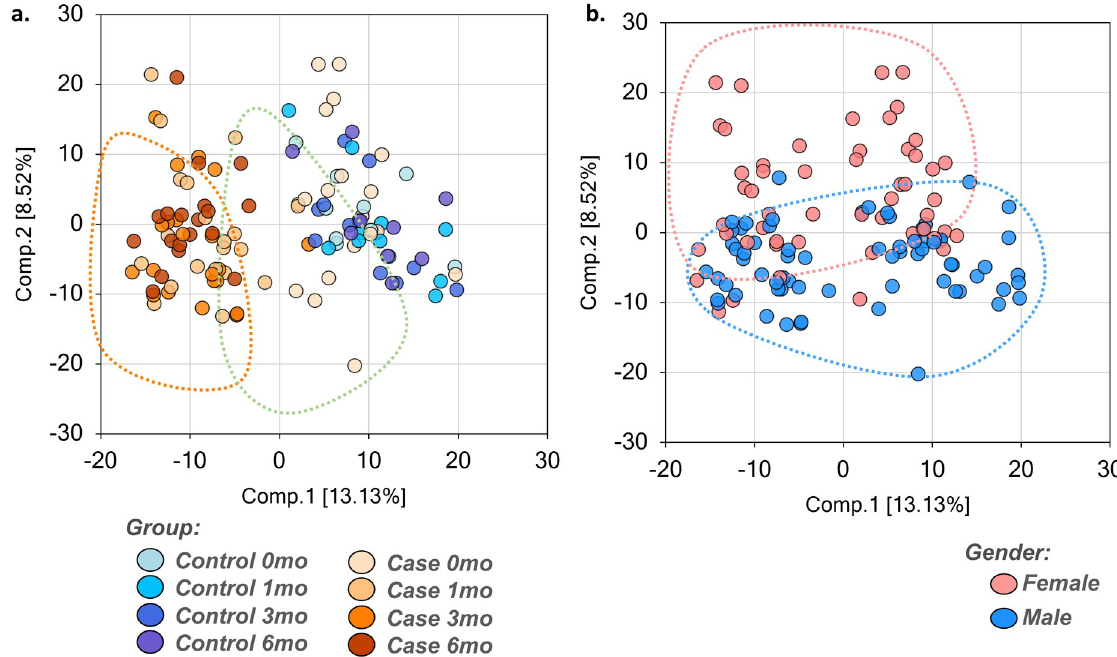
Fig 2. Principal component analyses involving 819 biochemicals detected in the dolphin serum metabolome, including demonstrated (a) shift of the metabolome among dolphins on the modified wild-type fish diet (‘Case’) compared to dolphins on the baseline fish diet (‘Control’), and (b) some separation of metabolites between females and